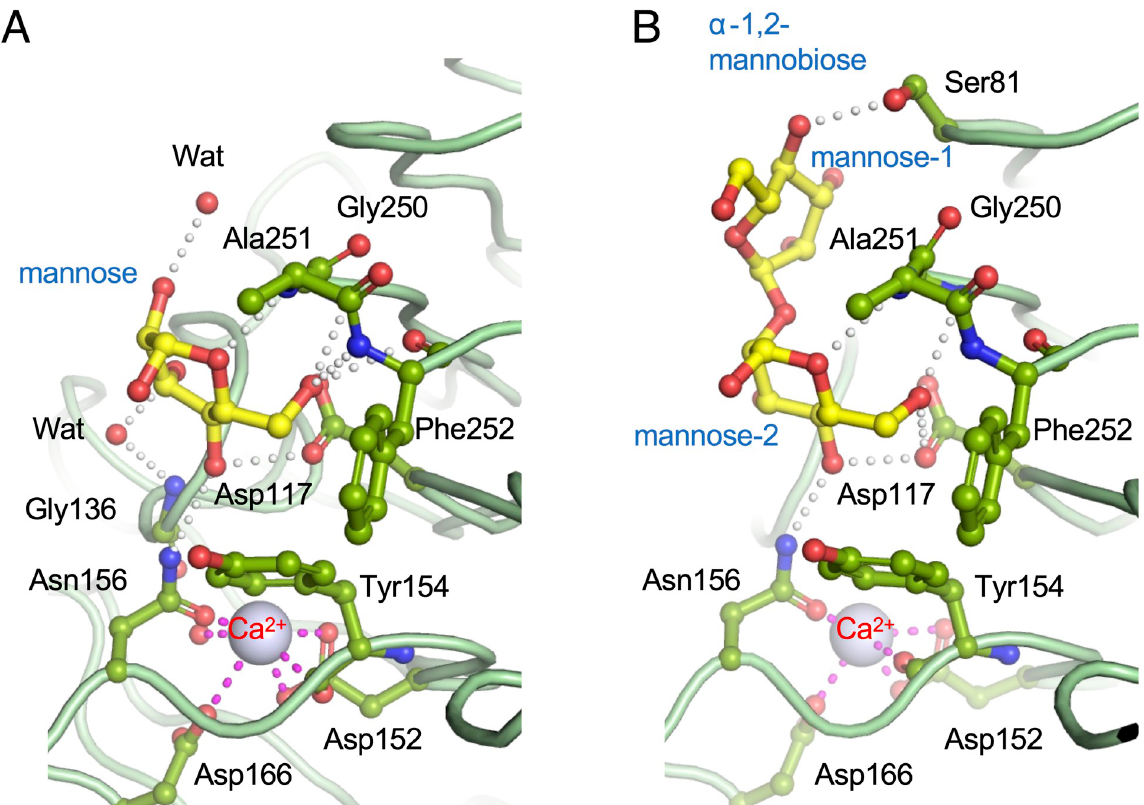
Fig 5. Substrate recognition by the YwfG Lec domain. (A) D -mannose and (B) α -1,2-mannobiose binding mechanism. The sugar substrate molecules and the YwfG residues that interact with these are indicated by the yellow and green ball-and-stick models, respectively. Calcium ions are shown as blue-white